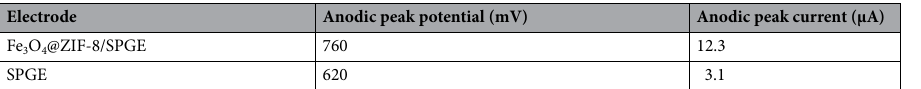
Table 1. Comparison the response of unmodified SPGE and Fe 3 O 4 @ZIF-8/SPGE to 100.0 µM sumatriptan in PBS (pH 7.0); scan rate 50 mV s −1 .